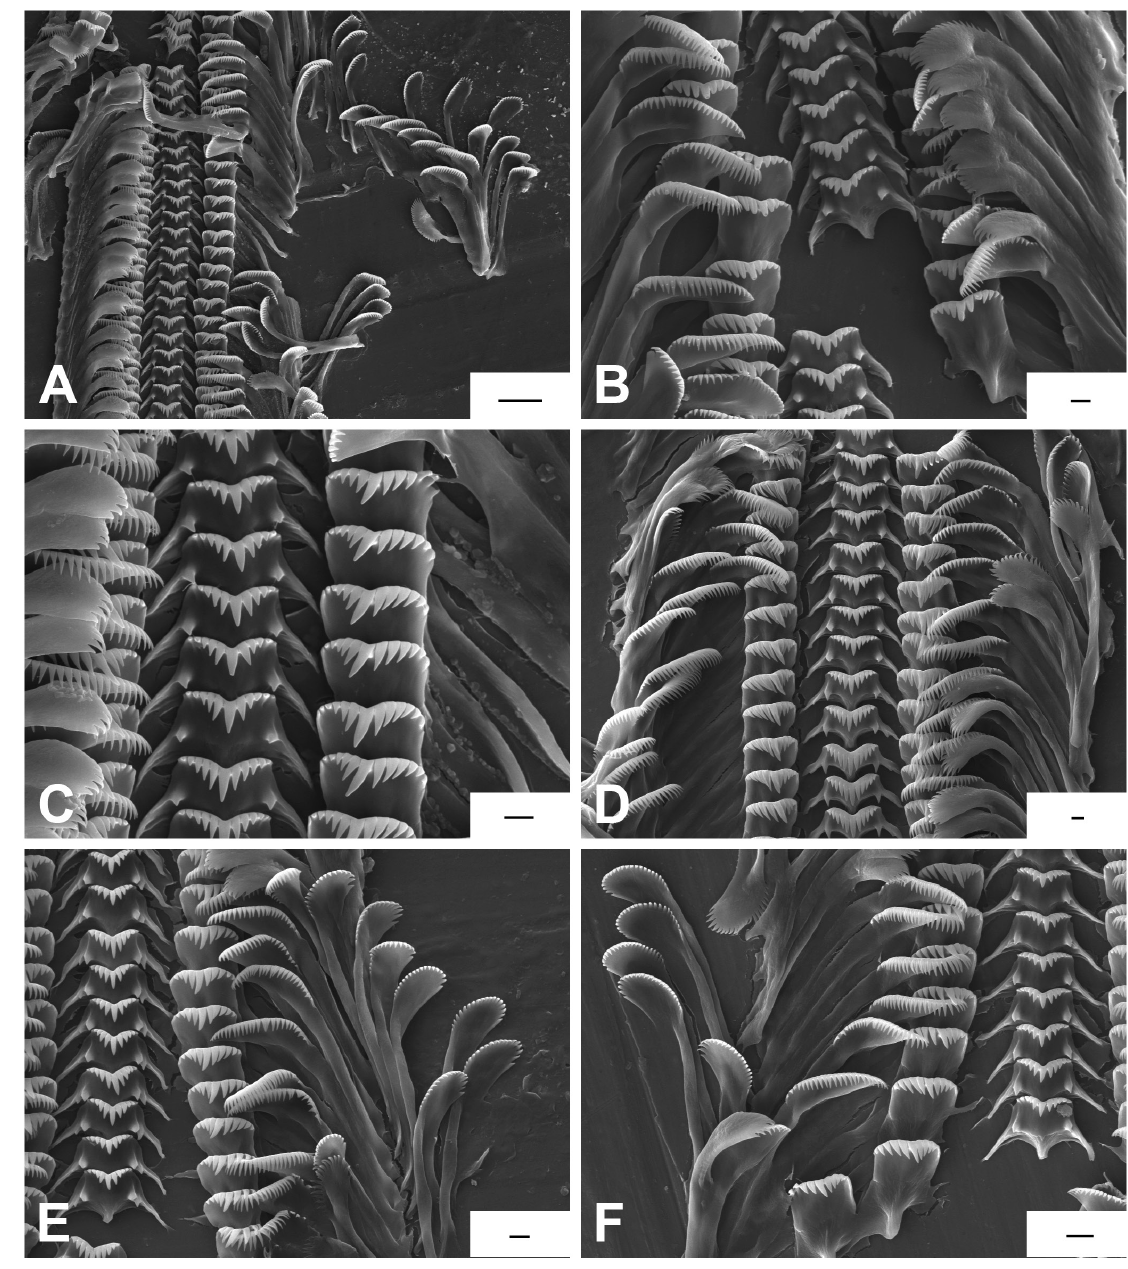
Fig. 15. Radulae (SEM micrographs). A–C . H. lozekiana sp. nov. D–F . H. steffeki sp. nov. D . Type locality. E–F . Spring Krivina (locality 74 from Table 1). Scale bars: A = 10 µm; B–E = 2 µm; F = 3